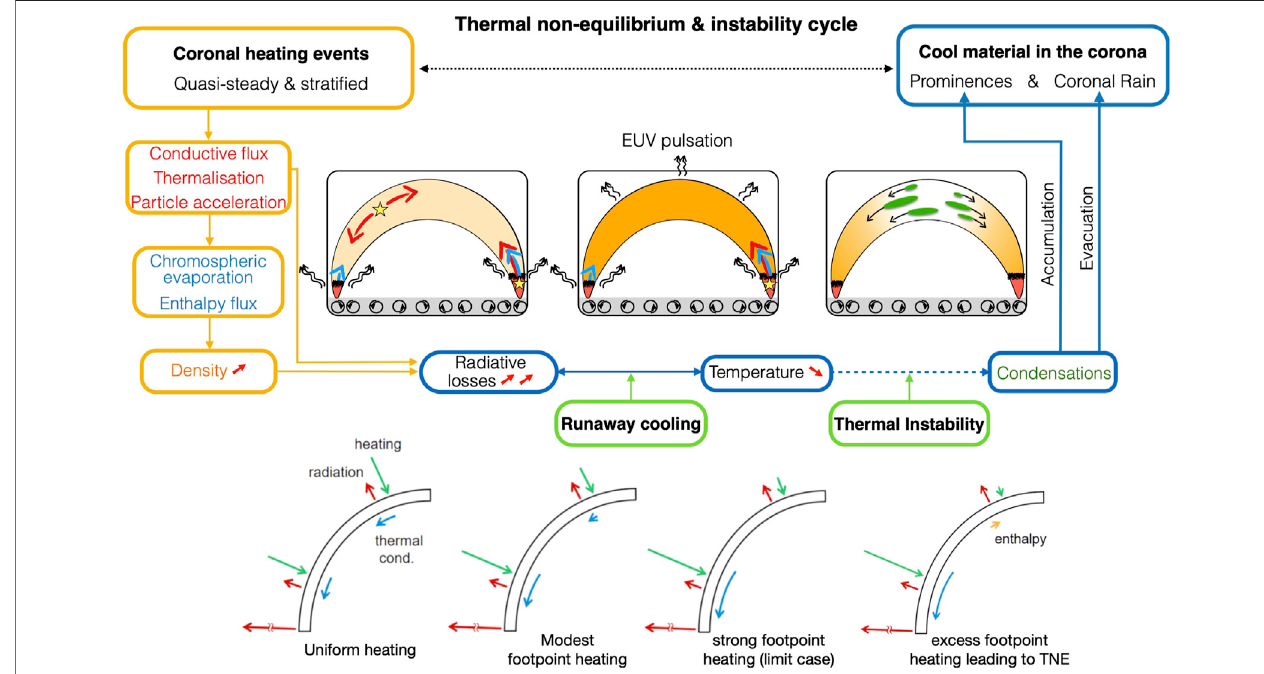
FIGURE1| TNE-TIcycle.Top:Asketchshowingthemainphysicalprocessesthatparticipateinthethermalnon-equilibrium(TNE)andthermalinstability (TI)cycle. Orange and blue boxes denote the heating and cooling phases, respectively. The 3 inset images with loops denote 3 instances through the cycle, ordered according to the TNE-TI sequence: heating events (yellow stars) occur either high up or lower down in the atmosphere. Thermal conduction (red arrows) distributes the heating. Chromospheric evaporation occurs (blue arrows), leading to dense loops (particularly in the case of footpoint heating). The loops get dense (second loop image) and emit strongly. Radiative cooling (wiggly black arrows) dominates over heating, leading to successive peaks of emission in gradually cooler EUV passbands (an EUV pulsation is observed in this stage). Under the right conditions (cf. §2.1.1) this process leads to runaway cooling. TI sets in, producing condensations (third loop image) that either accumulate in the corona to form prominences or fall as coronal rain. The loop evacuates and the cycle restarts. Adapted from Figure 3 of Antolin (2020). Bottom:Sketchexplainingthemainphysicalprocessesatplaywhenachievingthermalstabilityinaloop(halfaloopisshownhere,forsimplicity),andtheonsetofTNEfor the case of strongly strati fi ed heating. Adapted from Figures 1, 3 of Klimchuk and Luna (2019) (© AAS. Reproduced with